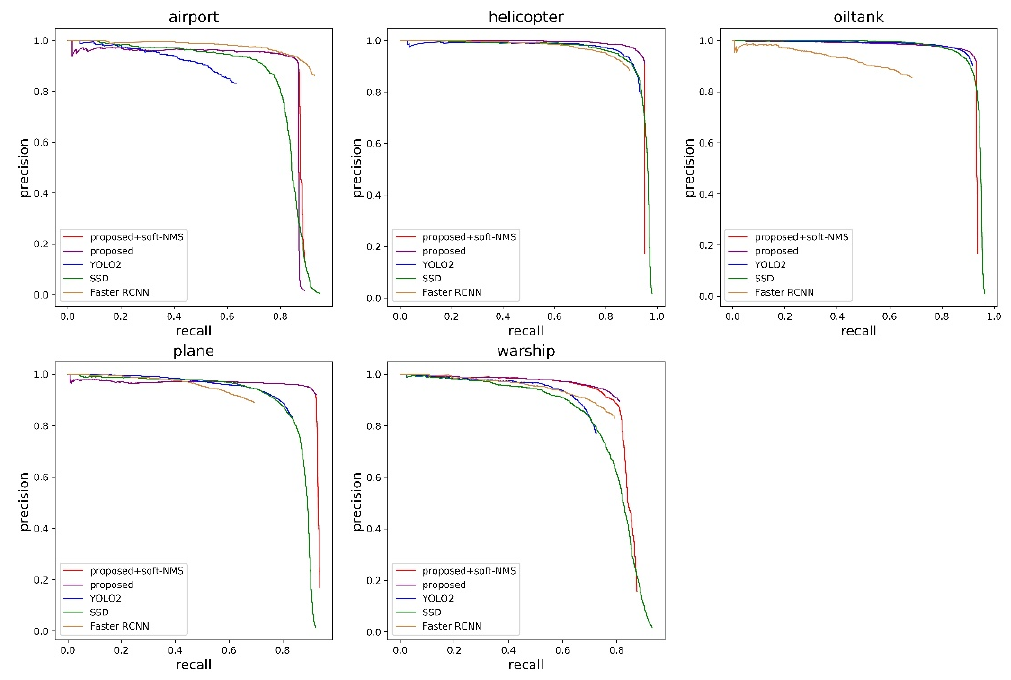
Figure 7. The precision recall curve of proposed approach and other comparison methods. Table 2. The average precision (AP) values of compared object detection methods on RSD-GOD dataset.